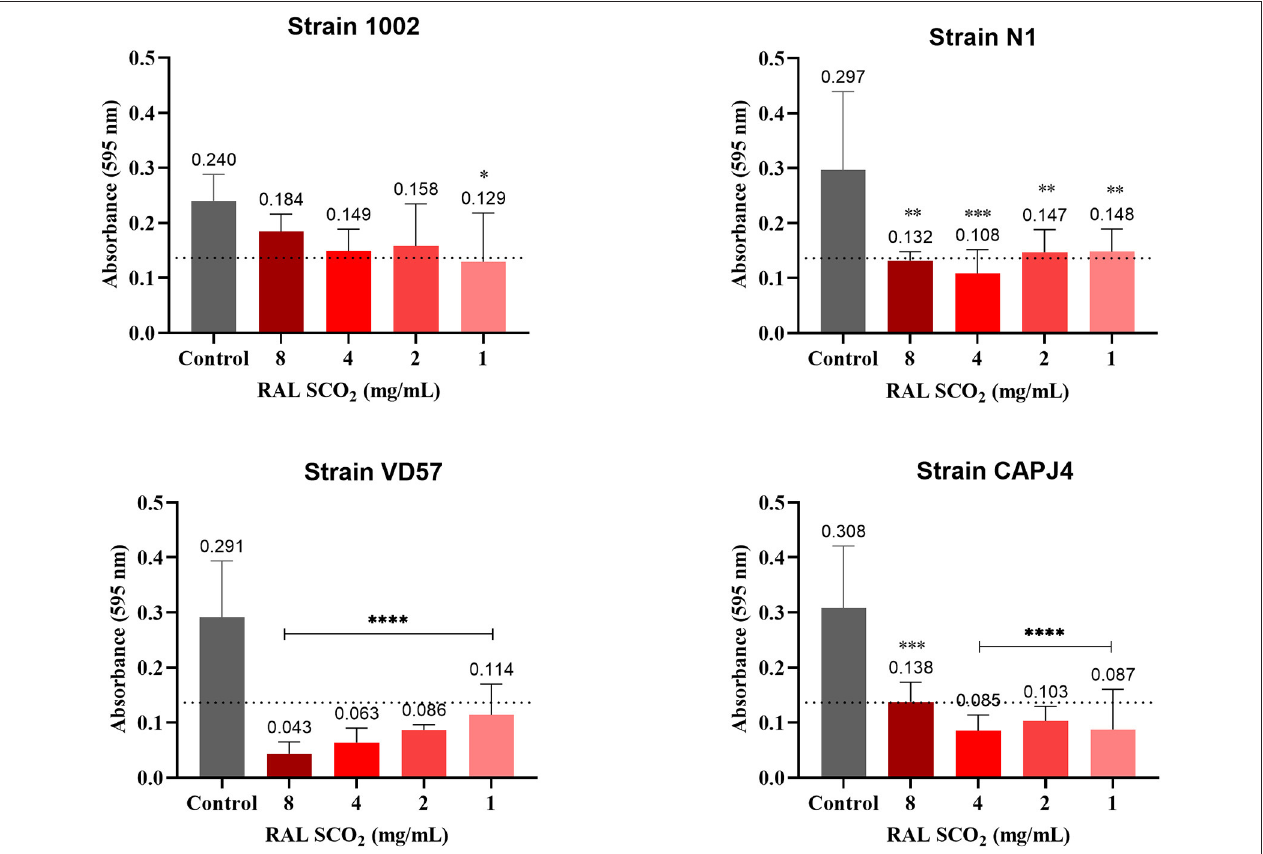
FIGURE 5 | Interference activity of the supercritical extract of red propolis (RAL SCO 2 ) in the formation of C. pseudotuberculosis biofilm: Strain 1002, Strain N1, Strain VD57, Strain CAPJ4. The dashed line in the graphs represents the cutoff point for significant biofilm production. Asterisks indicate statistical differences between untreated and treated bacterial cells analyzed using one-way ANOVA and t -tests. * p < 0.05; ** p < 0.04; *** p < 0.003; **** p <